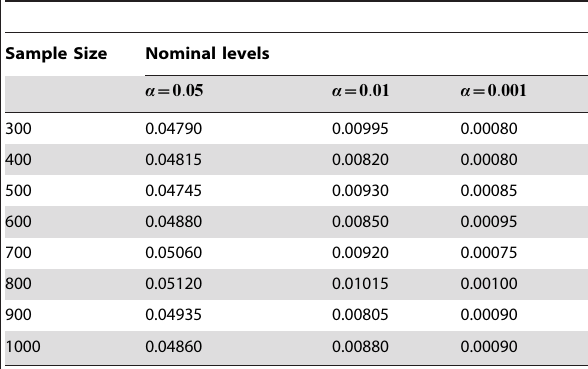
Table 1. Type I error rates of the statistic T IH to test for interaction between two loci, assuming OR G ~ OR H ~ 1